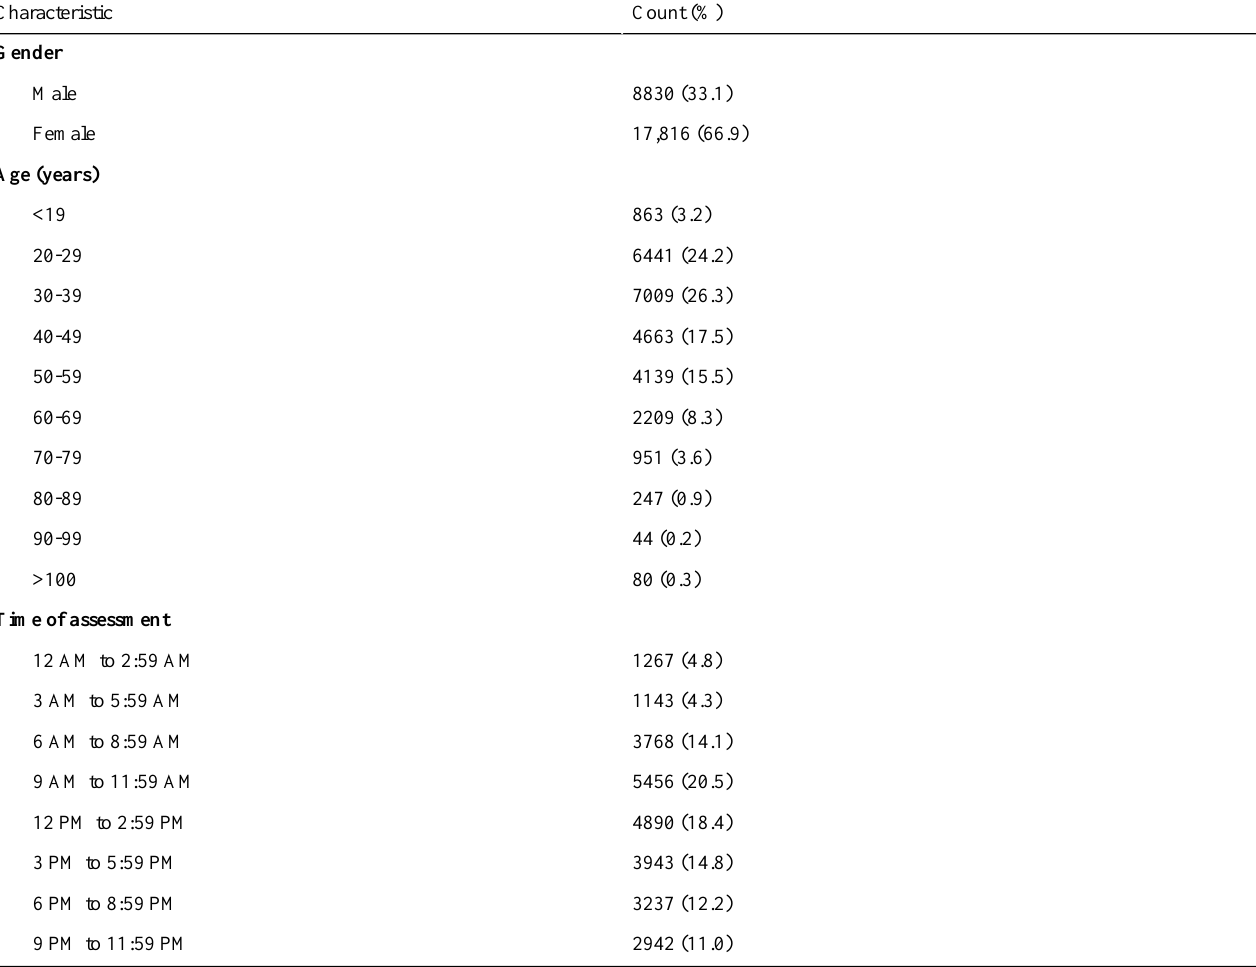
Table 1. Demographics and time of day of symptom checker use (N=26,646).